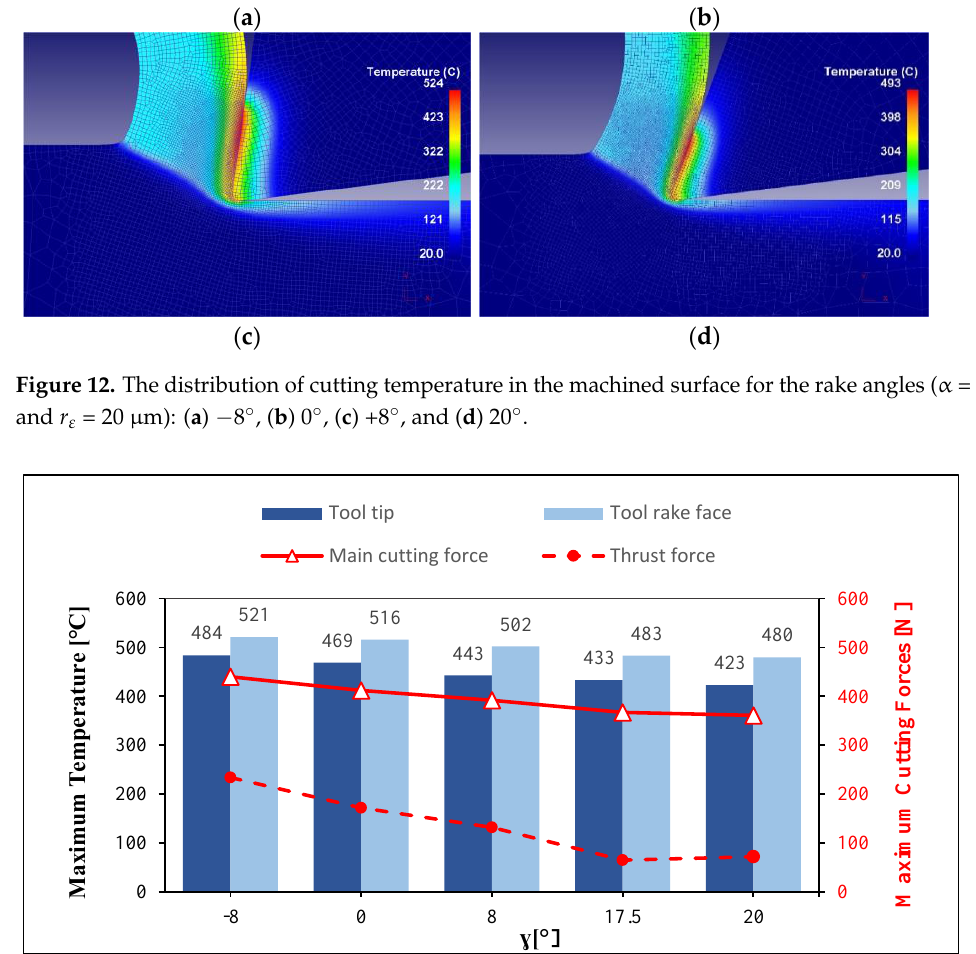
Figure 13. Relationship between the rake angle, force, and temperature.